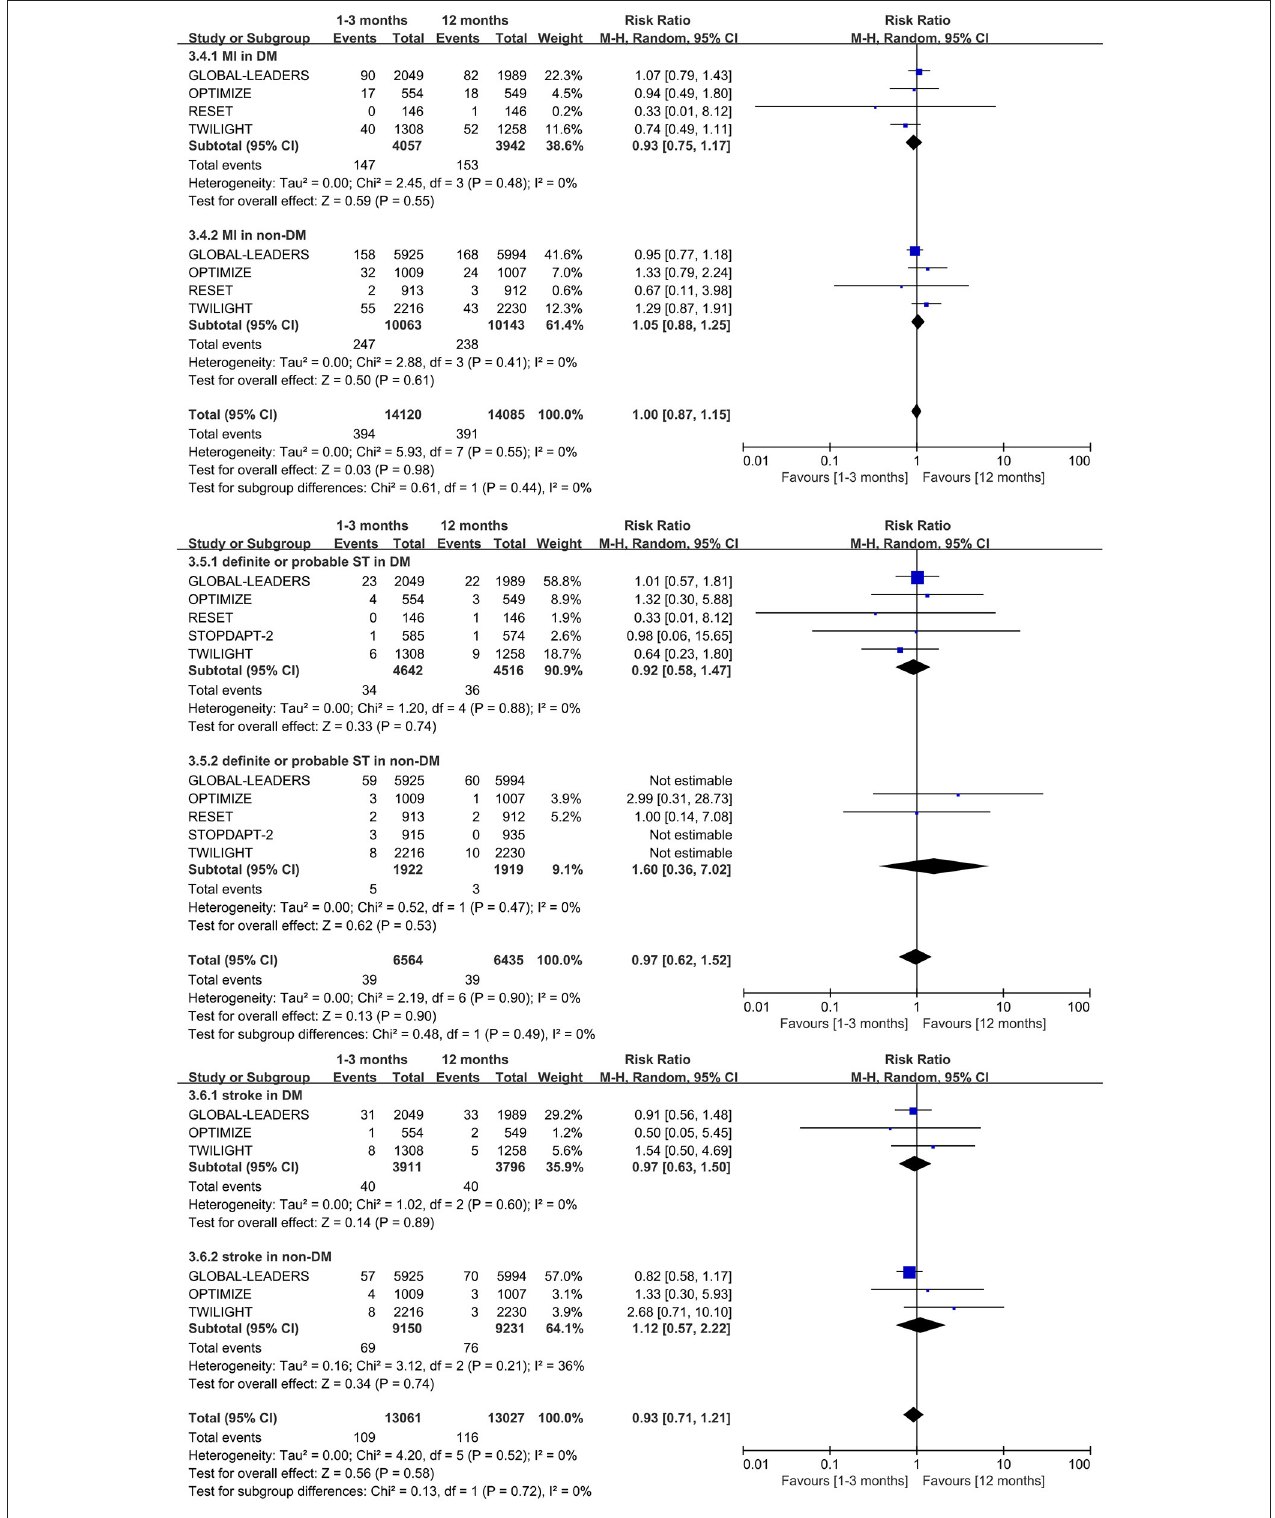
FIGURE 4 | Forest plot of other secondary outcomes in patients with or without diabetes mellitus according to duration of DAPT.